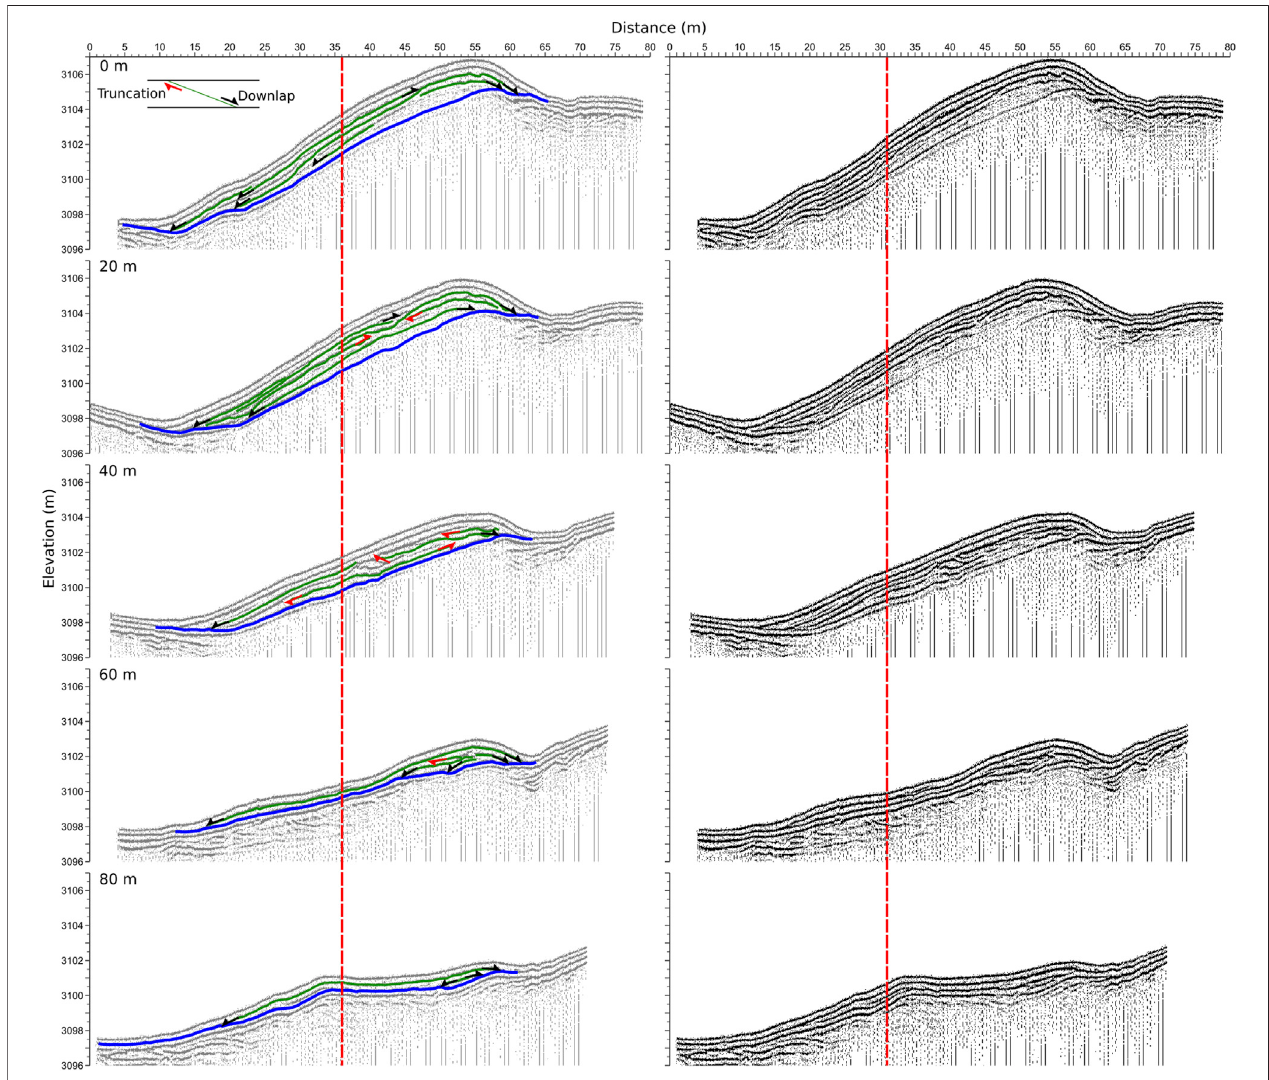
FIGURE 5 | Transverse GPR transects across the lobe of Blowout B at 20 m intervals perpendicular to the NW to SE bisect. The vertical axis is exaggerated by a factorof2.5.Theextractedbaseisdenoted bythethickerbluelineandinterpretationsoftheinternalboundingsurfacesareshownbythinnergreenlines.Thereddotted line indicates the intersection with the NW to SE bisect ( Figure 6 ). The uninterpreted GPR surveys are shown for reference.